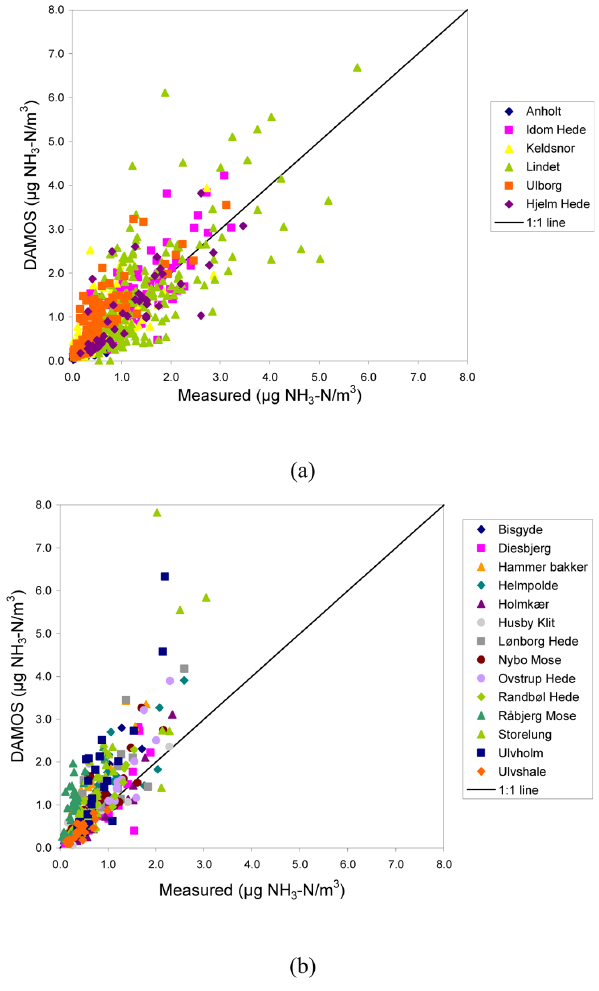
Fig. 5. Measured and modelled monthly or 1/2 monthly concentra- tions at the Danish sites (a) where the denuder method has been applied and (b) where the passive diffusion tube samplers ALPHA have been applied (see also Table 1 for more details about each site and Table 3 for the statistical